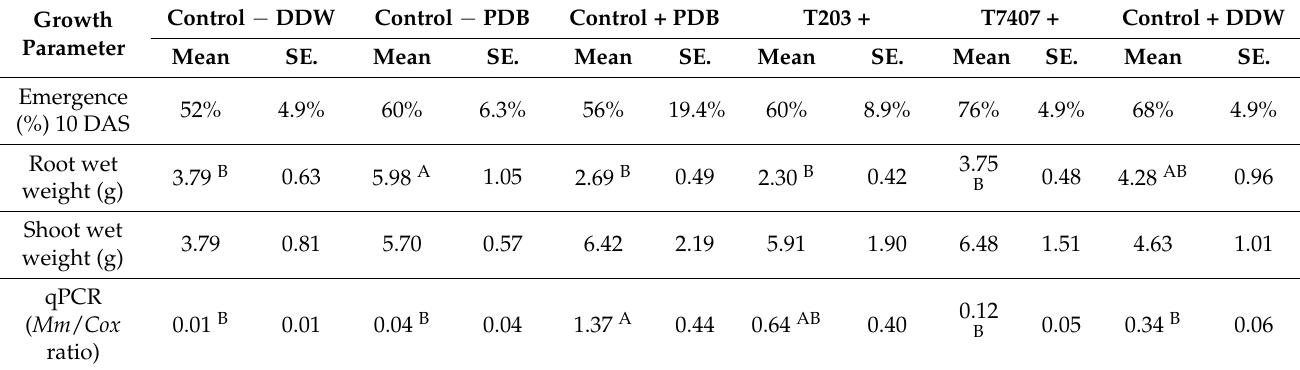
Figure 5. Effect of growth media of Trichoderma isolates on corn seed germination. The Trichoderma isolates are T. asperelloides (T203) and T. longibrachiatum (T7407). The seeds germinated in Petri dishes soaked in 4 mL of tap water (H 2 O), PDB, or PDB + secretion products (growth medium filtrate after 6 days Trichoderma isolates T203 or T7407 growth). Plate images are displayed after 5 days of incubation. Table 3. The effect of Trichoderma isolates secreted metabolites on the development of potted corn sprouts 1.